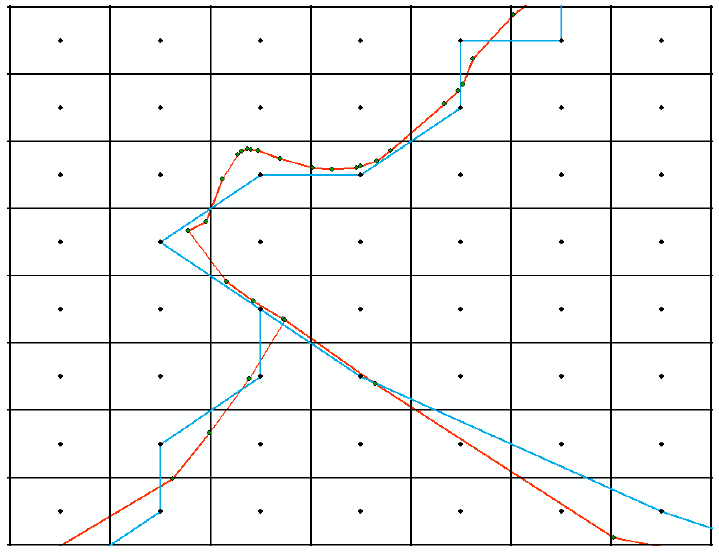
Figure 3. Grid filtering diagram.